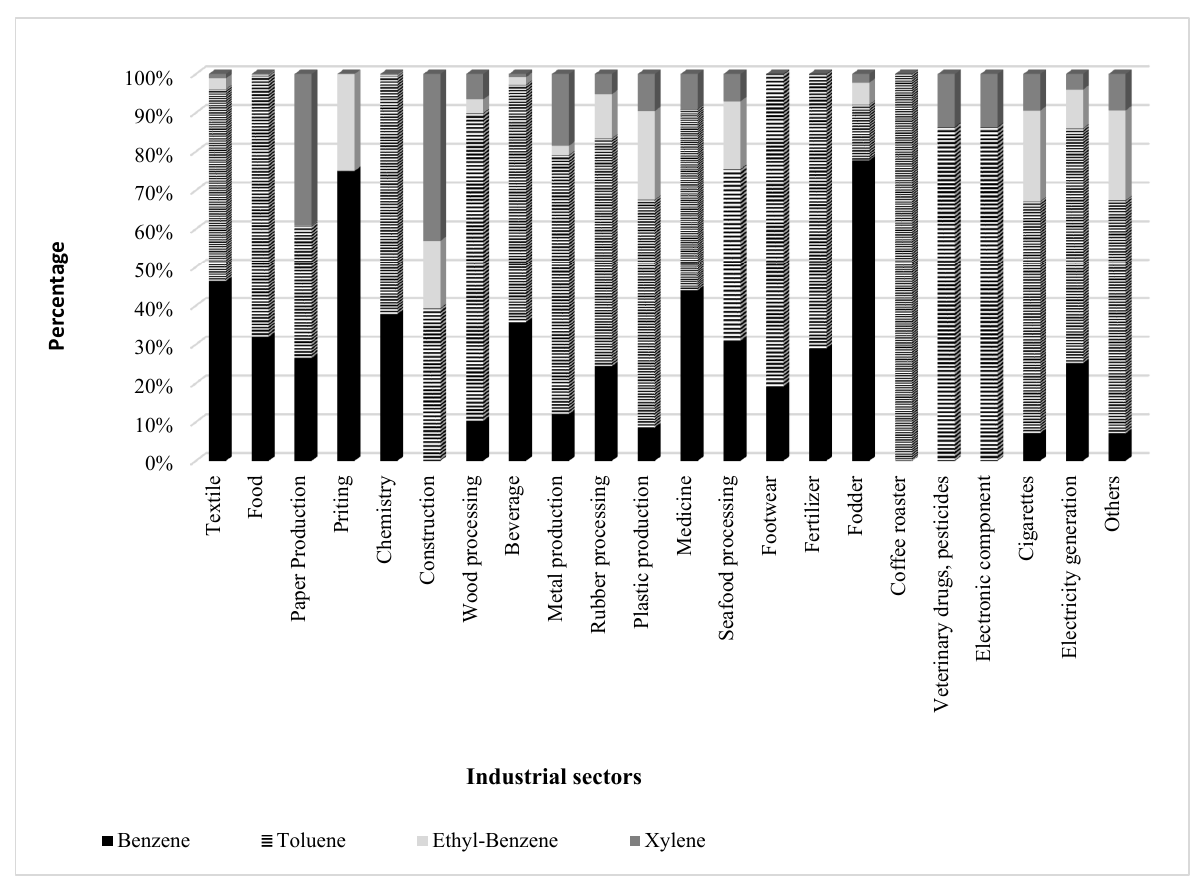
Figure 1. Contribution of BTEX emission load (kg/year) of industrial sectors of the point sources due to combustion fuel use and production by industry in HCMC. Fractions of different districts in Figure 2 show that suburban communities with industrial and manufacturing zones contributed primarily to the emission, such as Thu Duc, Tan Phu, Binh Chanh, and Hoc Mon. These districts have the majority of emissions because these areas are mainly industrial zones with relatively strong development in terms of industries. Toluene is prevalent in Binh Chanh, Tan Phu, and Thu Duc, with around 70% of total BTEX emission, while benzene and toluene had similar contributions in the Hoc Mon district with 42% of total BTEX emission (Figure 3). Five sectors contribute the most EI to BTEX. While most BTEX sources come from producing metal (nearly 99%), the textile, food, printing, and beverage industries mainly emit BTEX through combustion. The common materials in those sectors are DO, FO, gas, and charcoal. Table 4 below shows the emission (kgs/year) for these significant sectors due to producing and burning